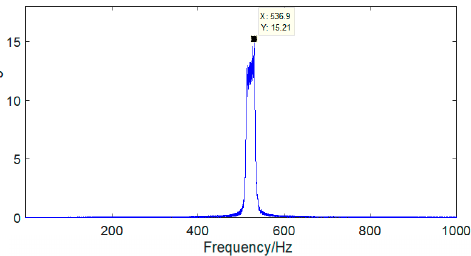
Figure 23. Frequency sweep vibration response of 304 stainless steel clamp with a 200 ‐μ m ‐ thick hard coating of 8% Y 2 O 3 ‐ Z r O 2 .